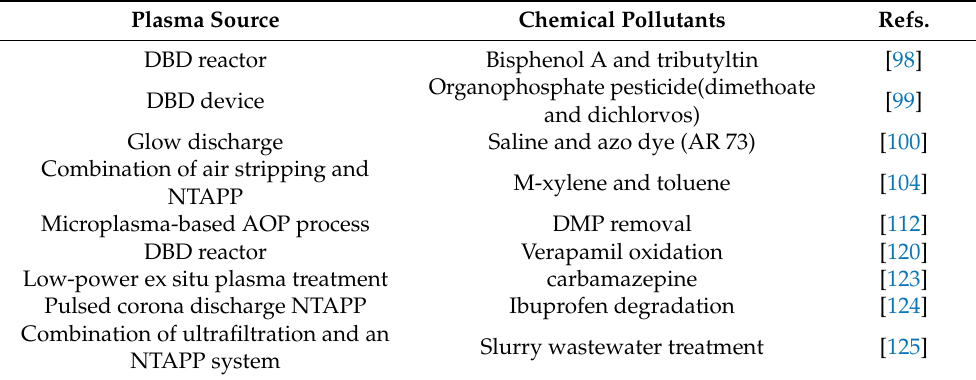
Table 2. Treatment approaches used for different